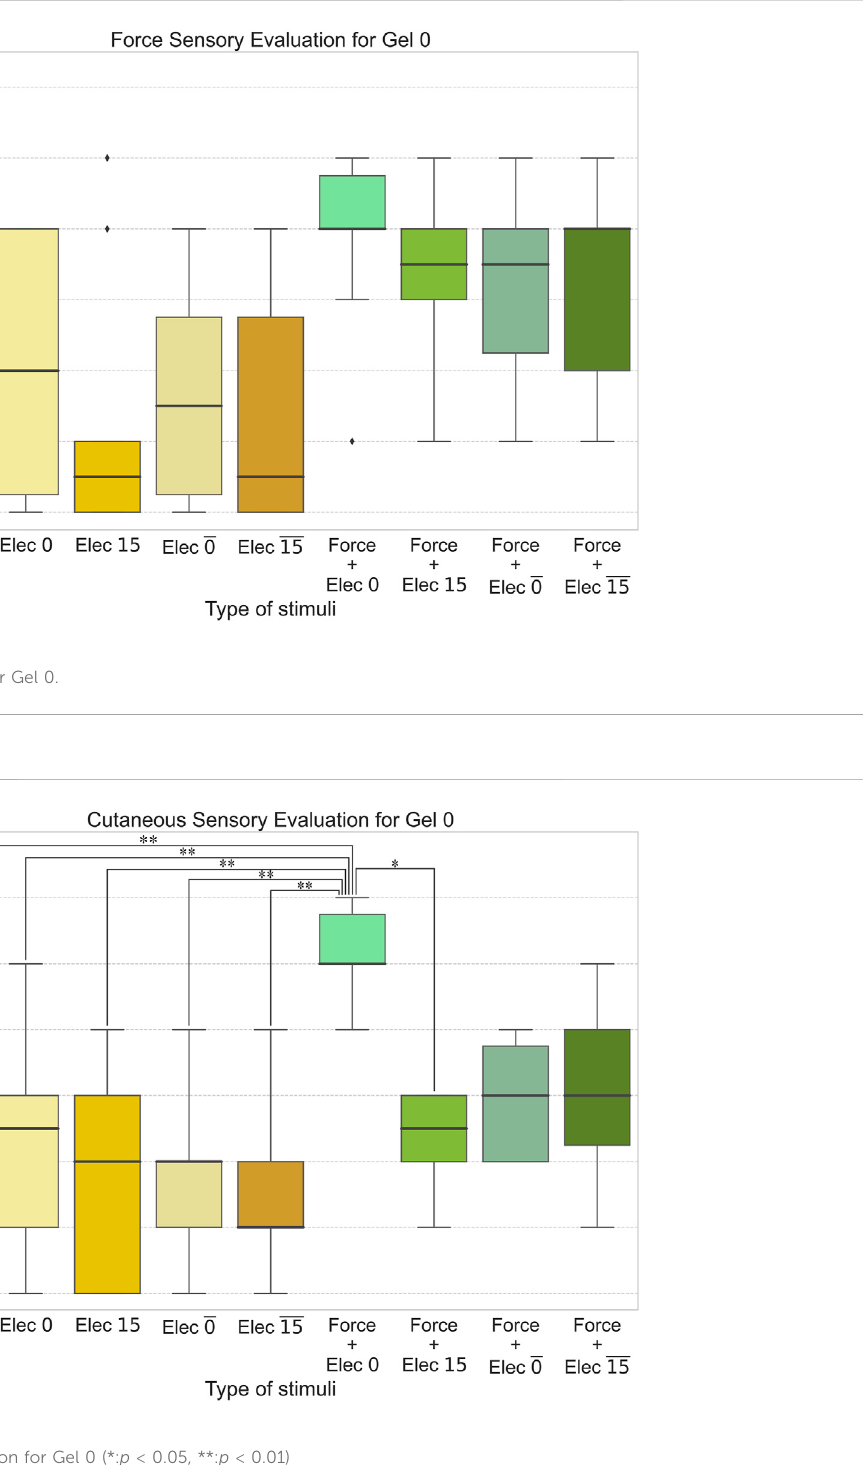
measured by TouchX. This may be the reason for the uniformly slightly off values when answering the Young ’ s modulus. To solve this problem, it would be necessary to measure or estimate the true fi ngertip position, taking into account the compression of the sponge.